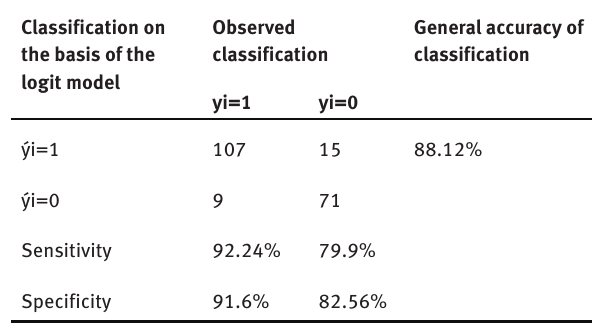
Table 14: Accuracy of classification of the logit model.